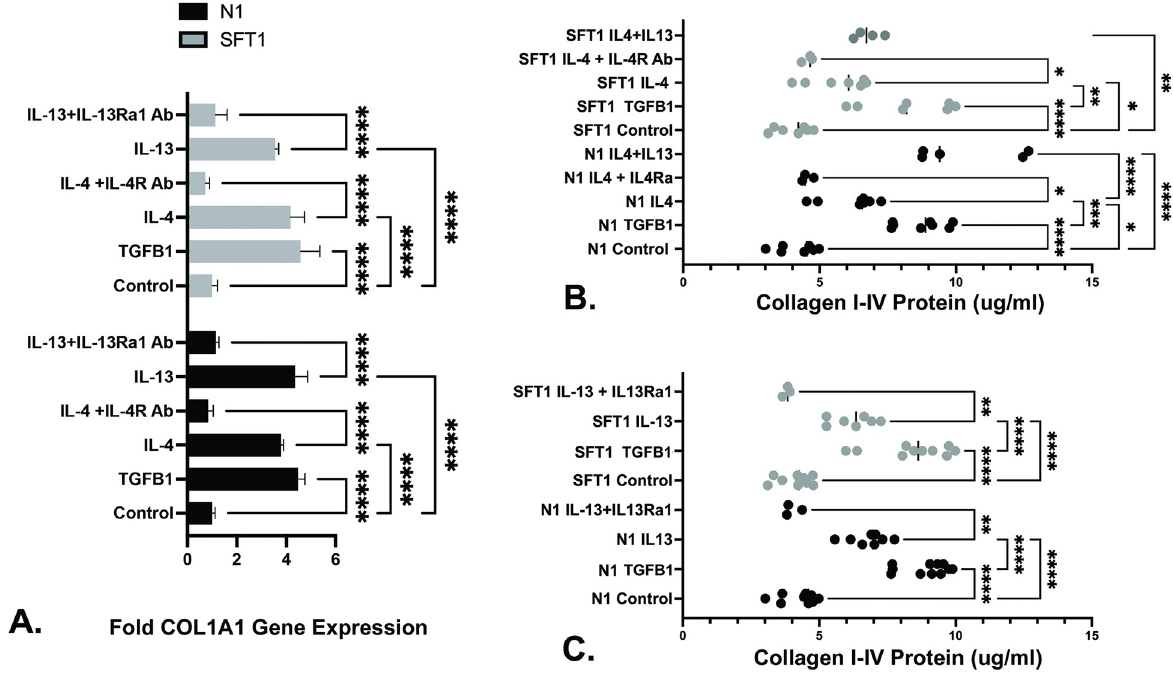
Fig 4. IL-4 and IL-13 increased collagen 1 gene transcription and collagen types I-V protein expression. A. Total RNA purified from N1 or SFT1 prostate fibroblasts cultured in serum-free media supplemented with vehicle or 20ng/ml IL-4, IL-13, or 4ng/ml TGF- β , for 24 hours with or without 2 hr pre-treatment with 400 ng/ml IL-4R α or 40 ng/ml IL-13R α 1 antibody was subjected to qRT-PCR and assessed for transcription of the RPLPO (housekeeping) and COL1A1 genes. Cycle numbers to threshold were calculated by subtracting averaged untreated from averaged treated values and normalized to those of RPLPO. Transcript levels are expressed as fold changes over control. IL-4 and IL-13 induced COL1A1gene expression to levels 3-4x higher, and TGF- β to level 4-5x higher, than vehicle-treated (control) cells. Pre-treatment with antibody against IL-4R α or IL-13R α 1 repressed COL1A1gene expression to near basal levels. Results shown represent the means of 3 experiments. Significant differences between paired comparisons are indicated as ���� p < .0001. Error bars represent SD. Data used to generate graph provided in S4 Fig. B, C. N1 or SFT1 prostate fibroblasts were cultured in serum-free media supplemented with vehicle or 20ng/ml IL-4, IL-13, or 4ng/ml TGF- β , for 48 hours with or without 2 hr pre-treatment with 400 ng/ml IL-4R α or 40 ng/ml IL-13R α 1 antibody. The cells were washed, lysed, and assessed for secreted soluble collagen types I-V using Sircol assay reagents. Both IL-4 ( B ) and IL-13 ( C ) significantly promoted collagen types I-V protein expression, which was ablated upon pre-treatment with IL-4R α or IL-13R α 1 antibody, respectively (S4 Fig). Significant differences between paired comparisons are indicated as � p < .05; �� p < .01; ��� p < .001; ���� p <